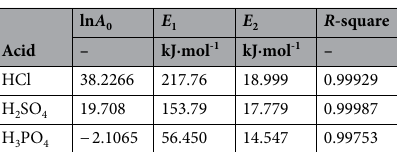
Table 2. Optimal Arrhenius parameters ( E i and ln A 0 ) from non-linear regression of Eq.